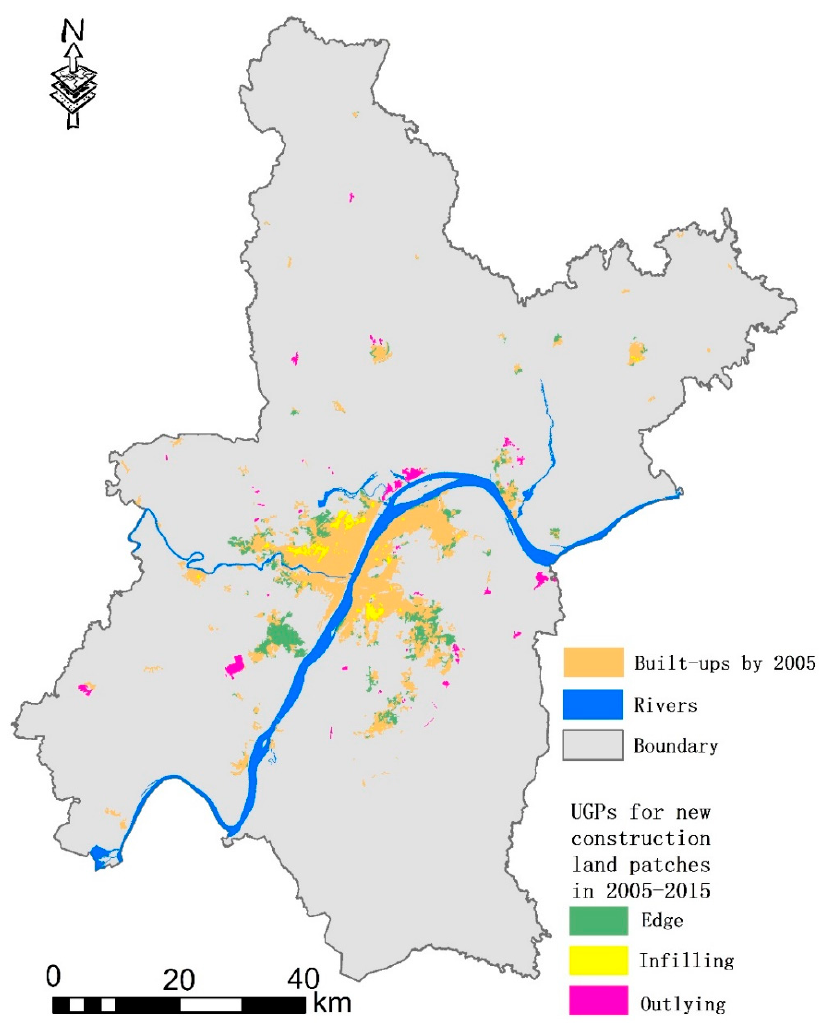
Figure 2. UGPs for new construction land patches in the study area from 2005 to 2015. We randomly selected 100 sample points from each type of patch. We used GIS to calculate the variable values at each sample point and, then, obtained the model variable parameters shown in Table 2. No variable had exactly the same positive or negative effects on the formation of the three types. For example, areas farther away from the city center and commercial centers were less favorable for infilling, but had a positive effect on edge and outlying growth. The distance from the existing built-up area had a strong positive relationship on outlying growth (4.569 ***), but not edge and infilling. The different effects of these three variables can be explained by the relationship between the spatial locations of the expansion types and the existing built-up areas. The findings that population agglomeration was associated with a higher probability of infilling or edge growth and that there was a lower correlation with outlying growth were similar to conclusions in a previous data mining study